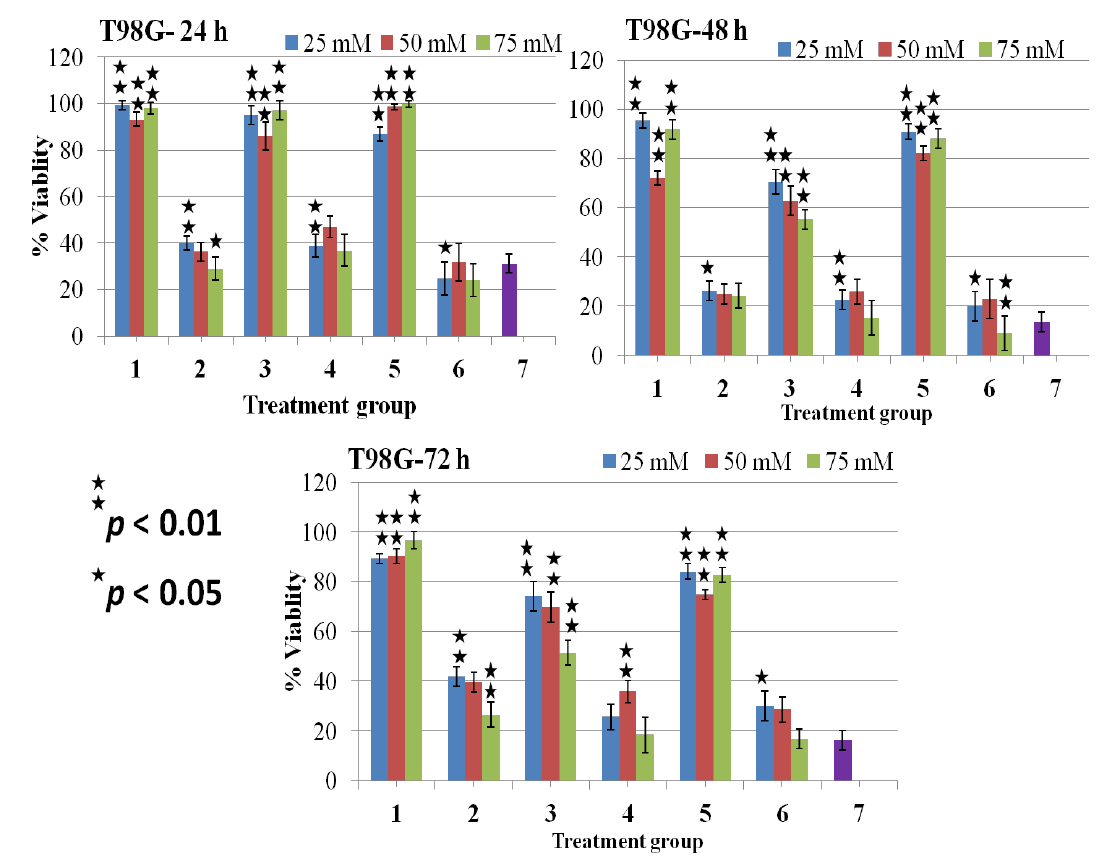
Figure 3. % Viability evaluated from MTT assay on treated T98G brain cancer cells at 24, 48, and 72 h. Data presented are mean ± SD of at least three independent experiments (n = 3) and statistically